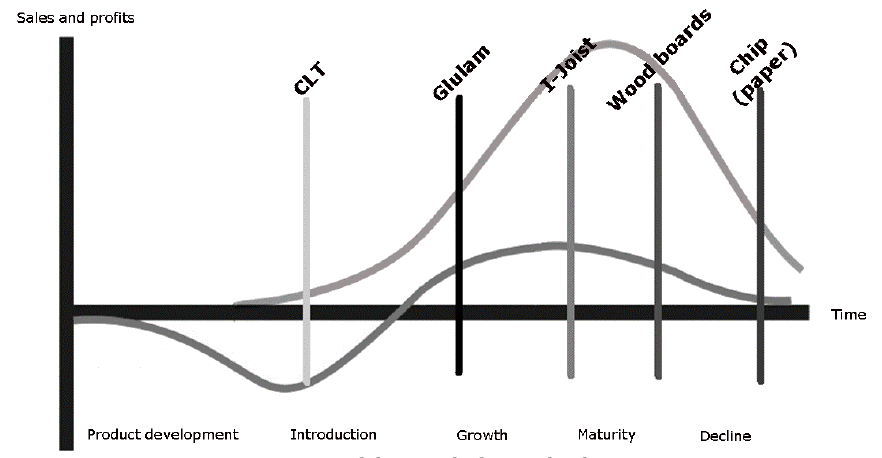
Source : inspired from Schuler and Adair,